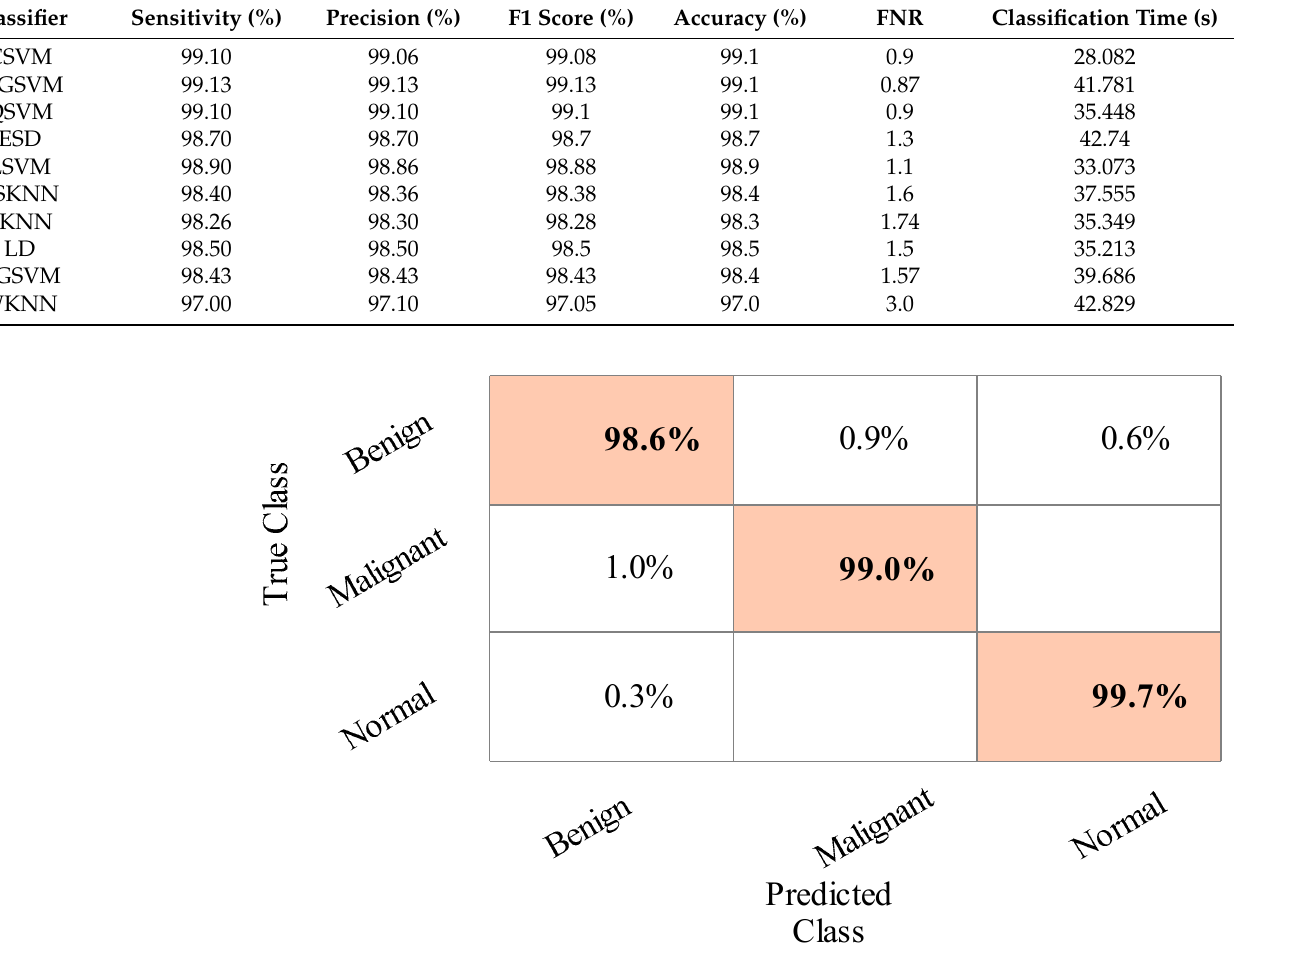
Figure 10. Confusion matrix of Cubic SVM for the features selected using DE and the train/test ratio of 50:50.